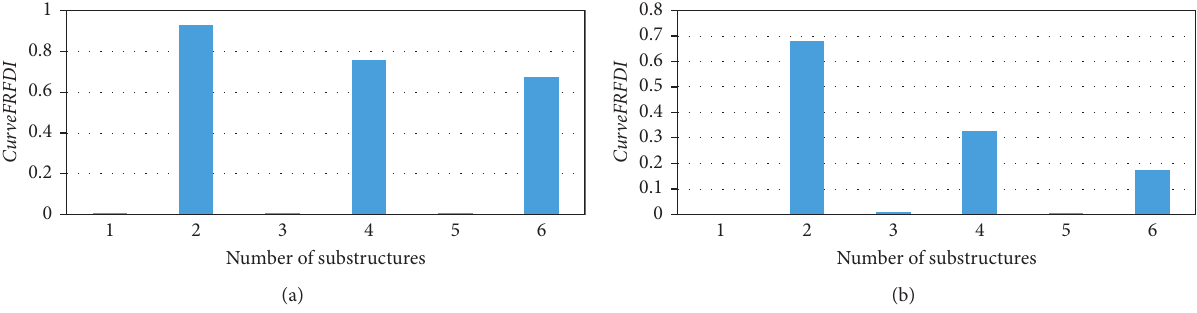
Figure 18: CurveFRFDI values for (a) case Dam_2F&4F&6F15% and (b) case